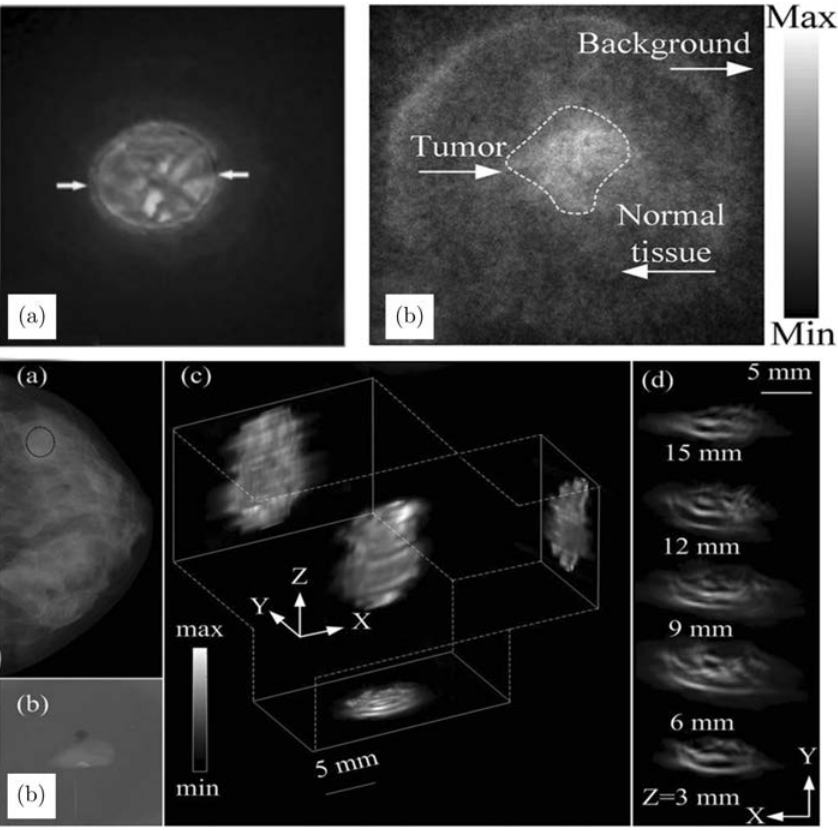
Fig. 12. The results of TAI of breast tumor. (a) Malignant breast tissue. 83 (b) The pathology model composed of excised human breast tumor and the excised breast of an adult ewe. 91 (c) Three-dimensional TAI experiment on breast model.